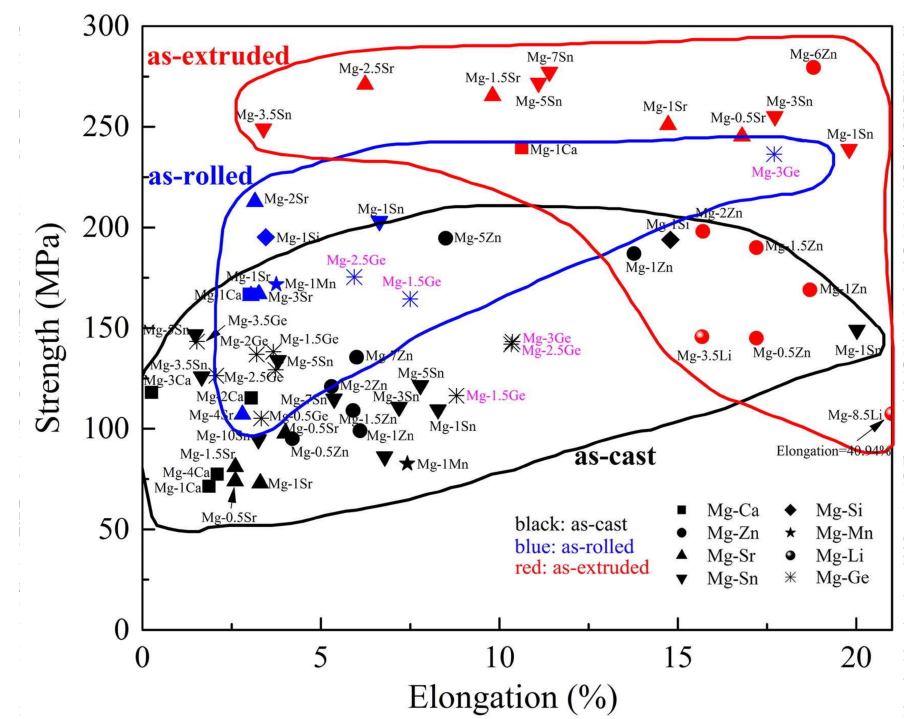
Figure 7. Comparison of the mechanical properties among various biodegradable Mg- X alloys ( X : essential/possibly essential element in human health). Different symbols represent different alloy systems and symbol color reflects the process condition, reproduced with permission from [114], Elsevier,